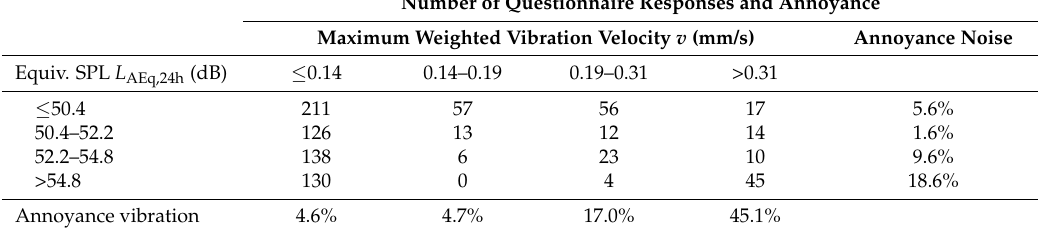
Table 4. Number of questionnaire responses and annoyance in quartiles of equivalent noise level (area 1) and maximum weighted vibration velocity (area 2).